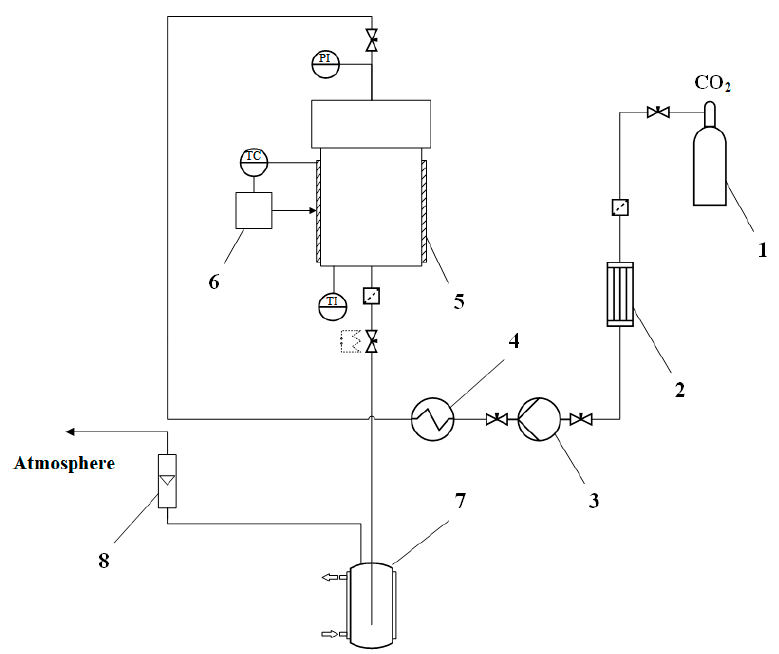
Figure 3. Diagram of a supercritical drying plant: 1—carbon dioxide vessel; 2—condenser, 3—high pressure piston pump, 4—thermostat, 5—high pressure apparatus; 6—thermal control system, 7—separator with a cooling jacket, 8—flow meter, PI—pressure gauge, TC—temperature sensor, TI—temperature sensor.